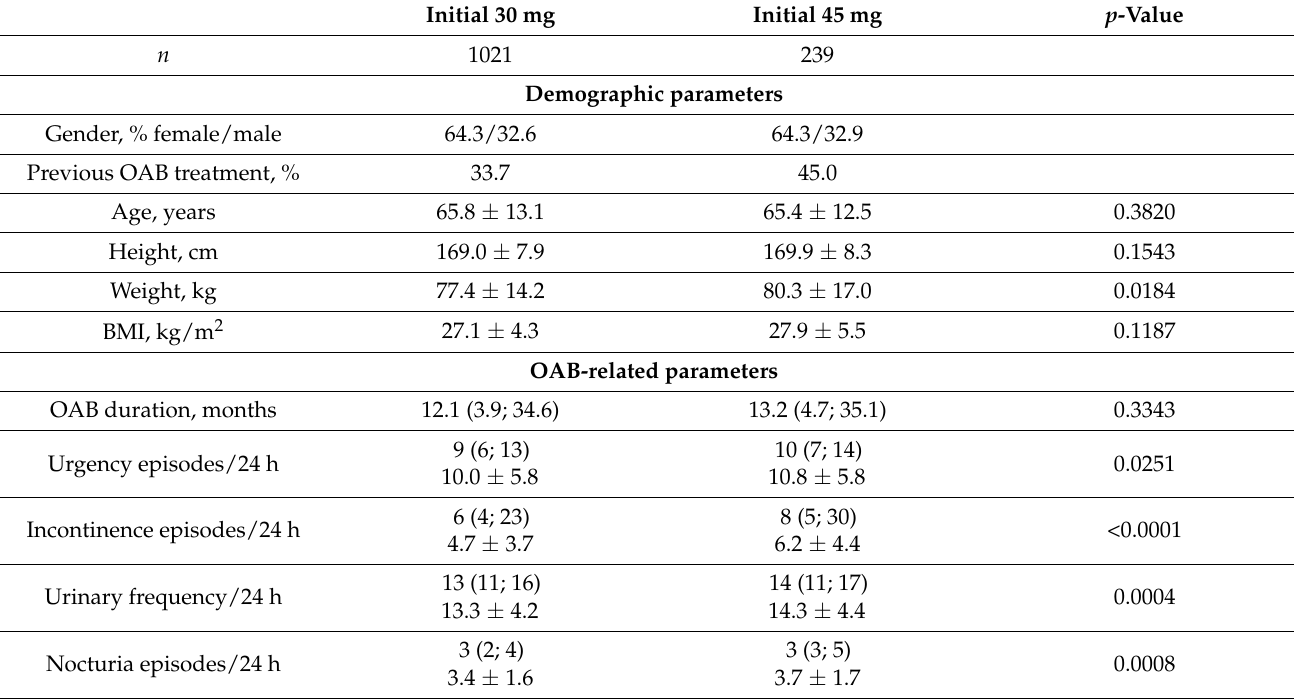
Table 1. Demographic and OAB-related baseline variables in patients starting treatment with a propiverine dose of 30 or 45 mg/d.